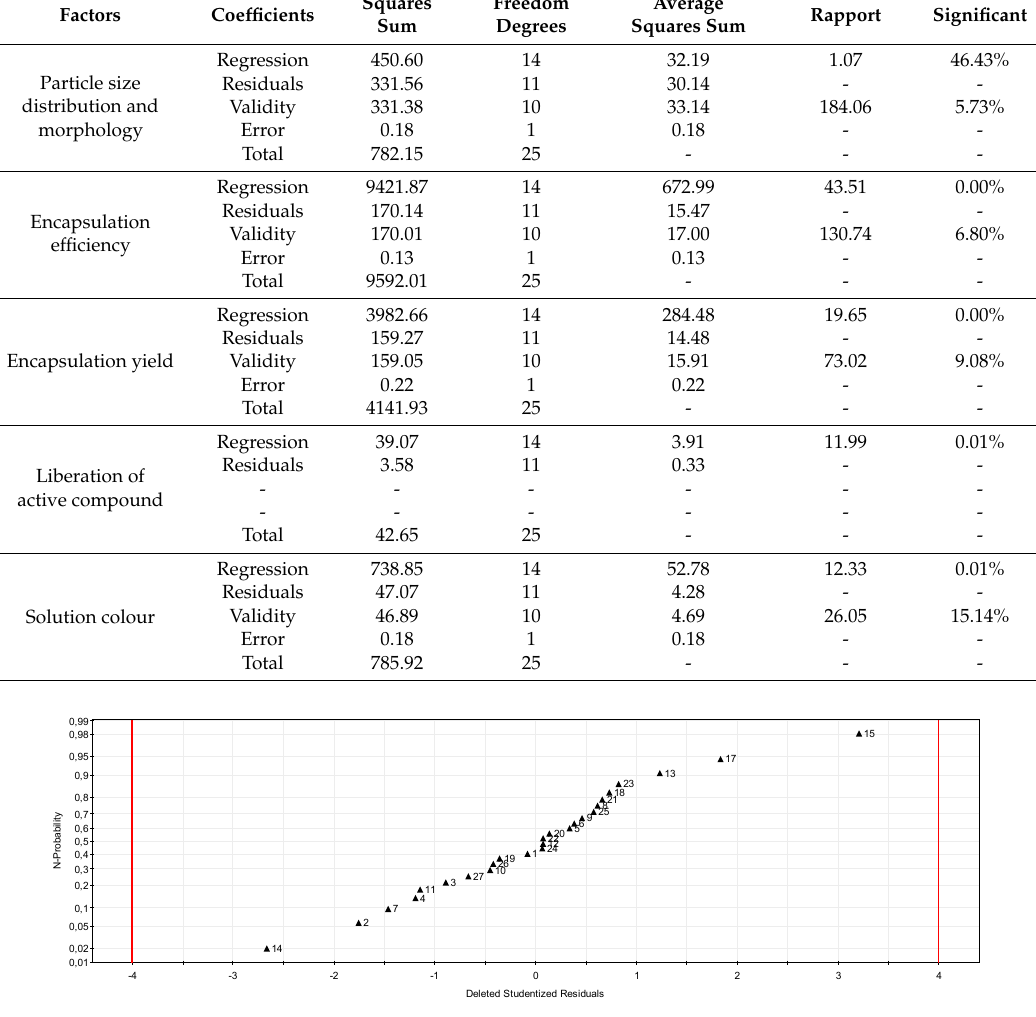
Table 6. Variance analysis of each response model. Table 6 Variance analysis of each response model. Table 6 Variance analysis of each response model.